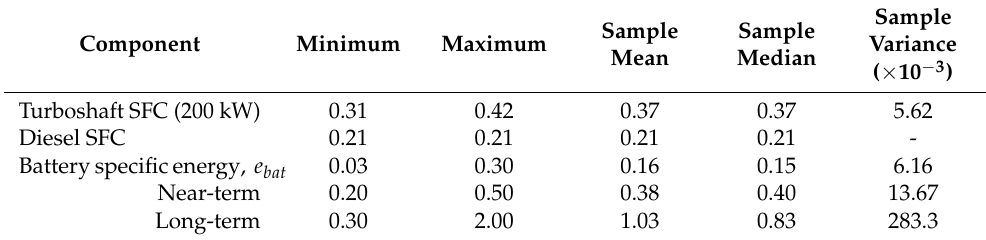
Table 5. Compiled values of state-of-the-art specific energy, e [kWh/kg] and Specific Fuel Consump- tion, SFC [kg/kWh], of energy